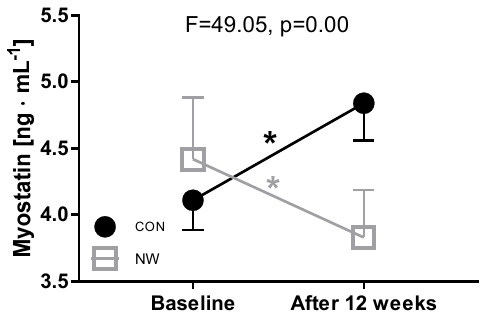
Figure 2. Changes in MSTN levels after 12 weeks, * p < 0.05.